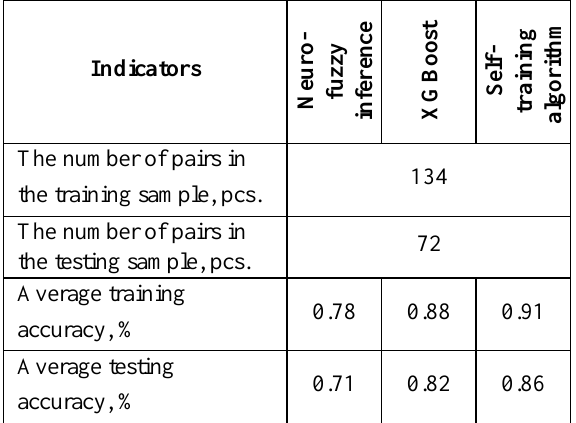
Fig. 1. The membership functions for evaluation by subcriteria